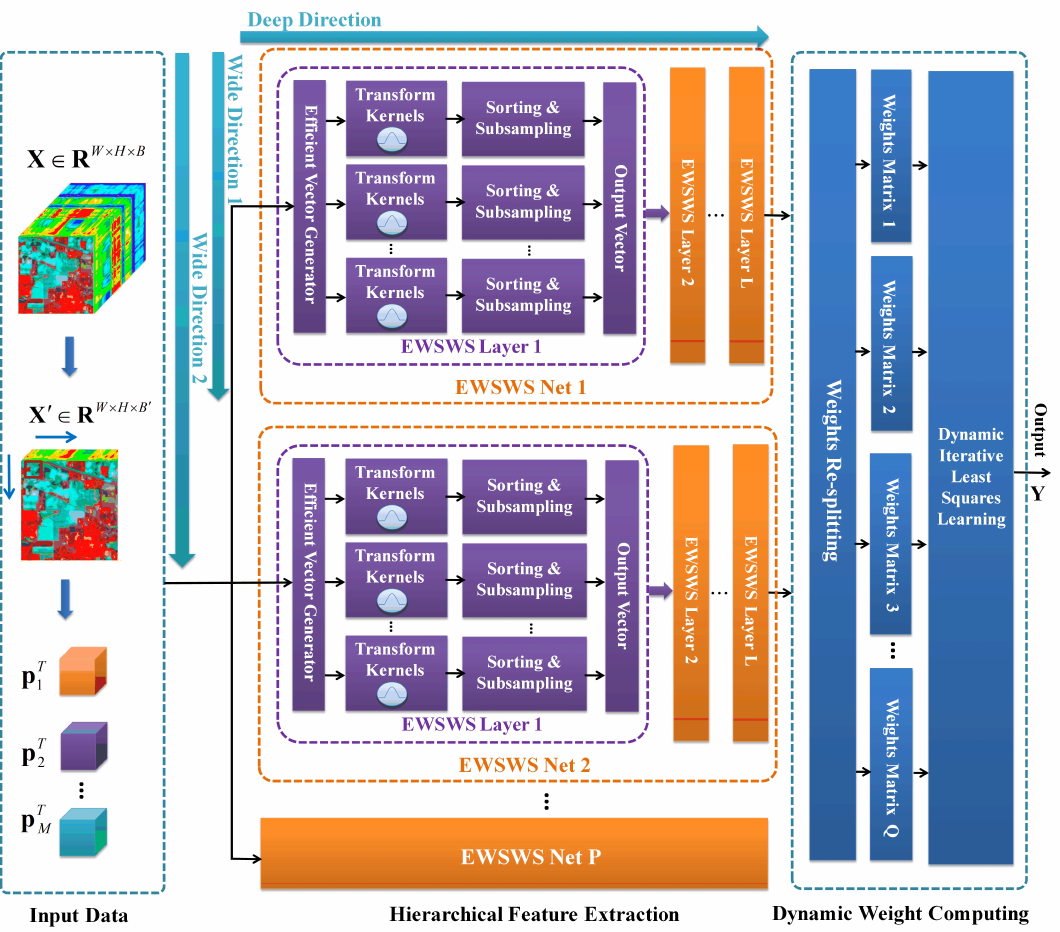
Figure 1. Architecture of the DWDNN. The DWDNN is composed of multiple EWSWS networks, which are generated in the wide direction. Each EWSWS network has L layers of transform kernels with sliding windows and strides in the deep direction. Each WSWS layer can be extended in the wide direction. Therefore, the DWDNN can learn features effectively with both the wide and deep architecture. The parameters of these transform kernels can be learned with randomly chosen training samples. The weights of the DWDNN are mainly in the fully connected layer and can be learned easily using iterative least